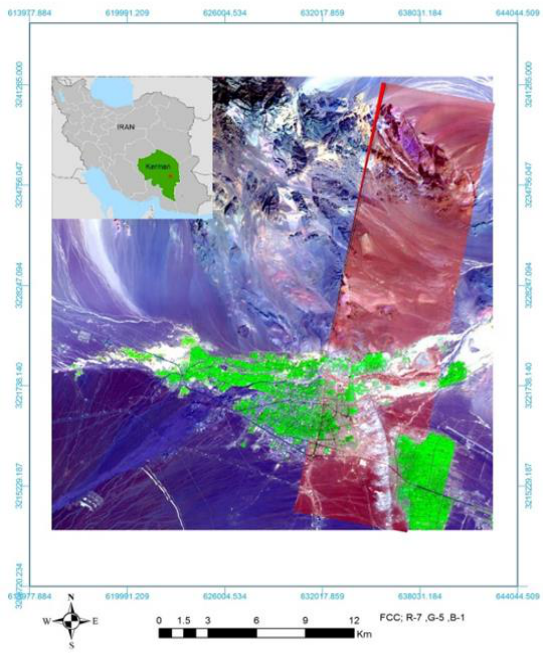
Figure 1. Location of study area and its satellite